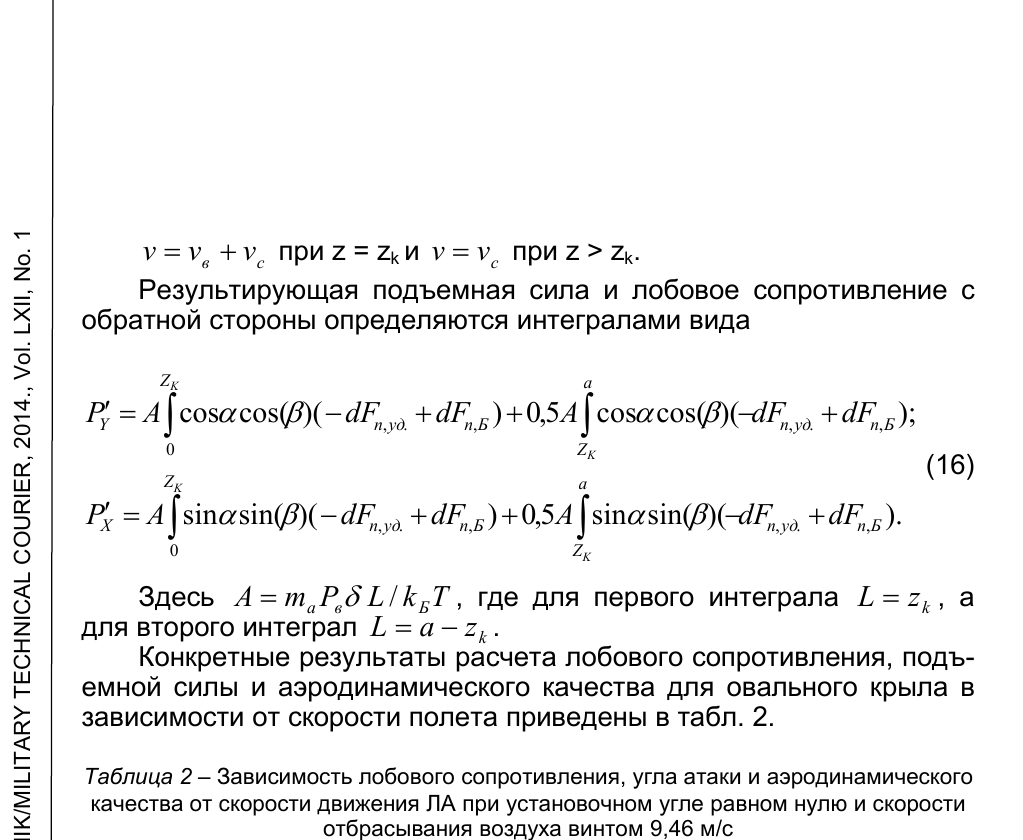
Table 2 – Dependence of resistance, attack angle and aerodynamical characteristics on the aircraft speed for the installation angle equal to zero and the speed of air thrusted by blades of 9.46